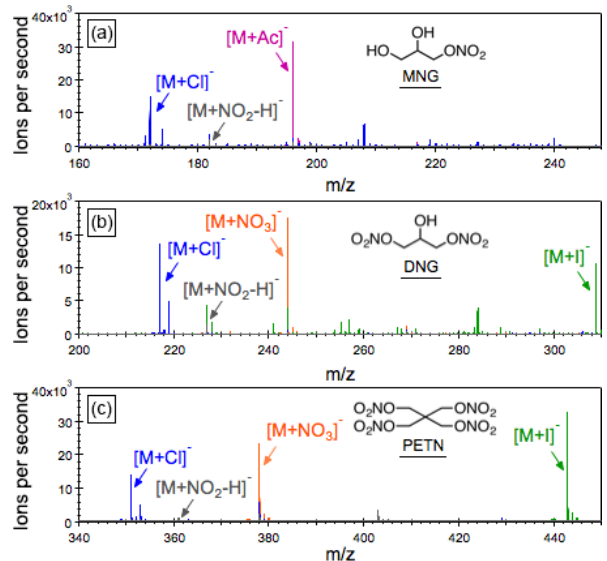
Figure 1. Negative ESI mass spectra of 5µM 1-mononitroglycerin (MNG), 1,3-dinitroglycerin (DNG) and pentaerythritol tetranitrate (PETN) dissolved in pure methanol (gray), methanol with 0.1mM ammonium acetate (NH 4 Ac; purple), methanol with 0.1mM am- monium chloride (NH 4 Cl; blue), methanol with 0.1mM sodium ni- trate (NaNO 3 ; orange) and methanol with 0.1mM sodium iodide (NaI; green). These three alkyl nitrates, which do not readily pro- duce a significant amount of molecular ions on their own during negative ESI, are observed as clusters with acetate (Ac − ), chloride (Cl − ), nitrate (NO − ) and iodide anions (I − ) in the ESI( − ) 3